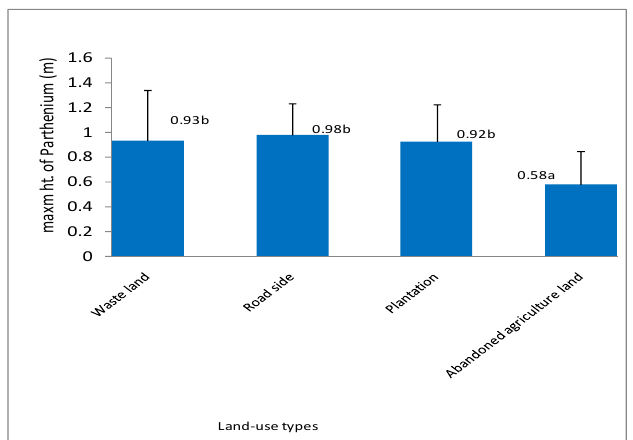
Fig. 6: Maximum height of Parthenium in different land-use types. The mean values were compared by ANOVA (F 3, 116 =10.15; P<0.001) followed by Duncan homogeneity test. The values with same alphabet in superscript are not significantly different at P=0.05 y = 0.01x + 3.988 R² = 0.218